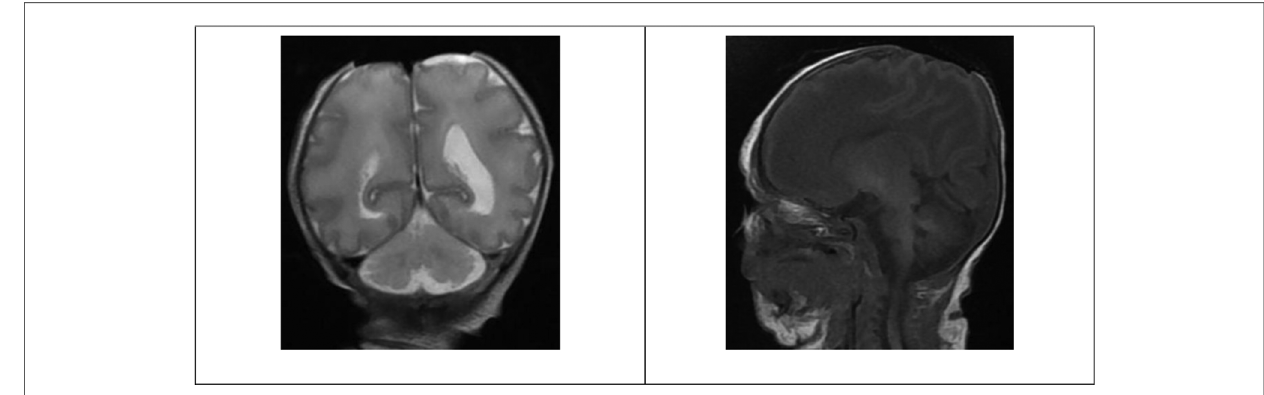
FIGURE 2 Patient head MRI. Selective images of the MRI coronal T2 and sagittal T1-weighted images showing the absence of scalp and calvarium in the parietal region with no